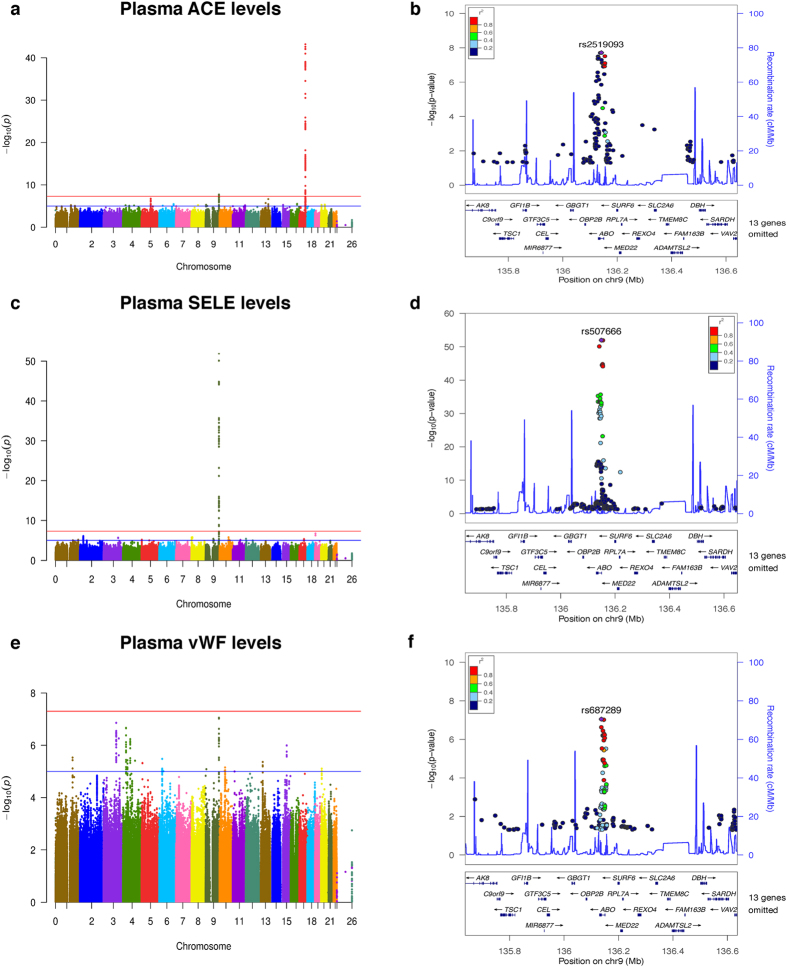
Manhattan and regional plots for pleiotropic ABO variant associations with plasma levels of ACE, SELE, and vWF.(a) Manhattan plot of −log10 p-values for association with plasma levels of ACE; (b) Regional plot for genome-wide significant associations in ABO locus with ACE plasma levels; (c) Manhattan plot of −log10 p-values for association with plasma levels of SELE; (d) Regional plot for genome-wide significant associations in ABO locus with SELE plasma levels; (e) Manhattan plot of -log10 p-values for association with plasma levels of vWF; (f) Regional plot for associations in ABO locus with vWF plasma levels, rs687289 was close to genome-wide significance (p = 8.87 × 10−8).